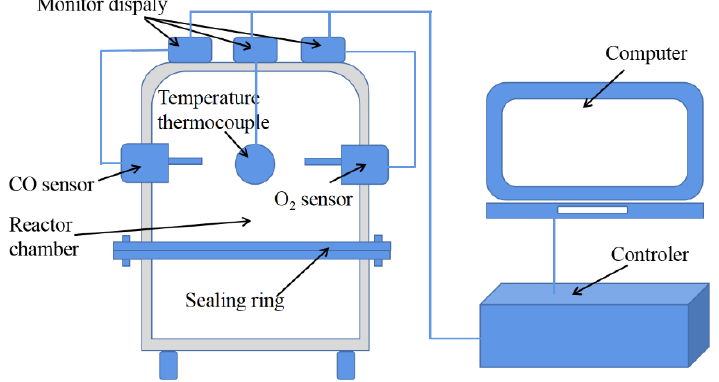
Figure 1. Schematic diagram of the ambient temperature oxidation device.